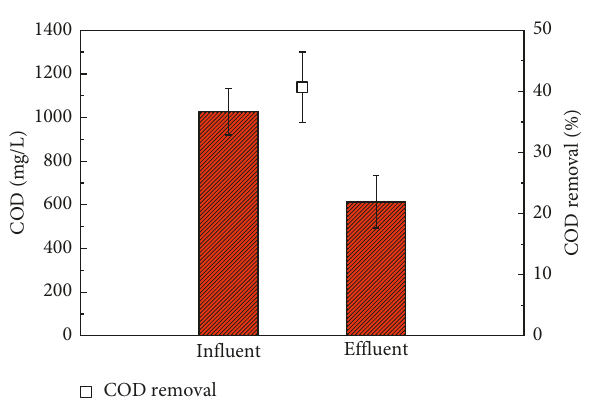
Figure 2: COD of the influent and effluent and COD removal rate of the effluent.